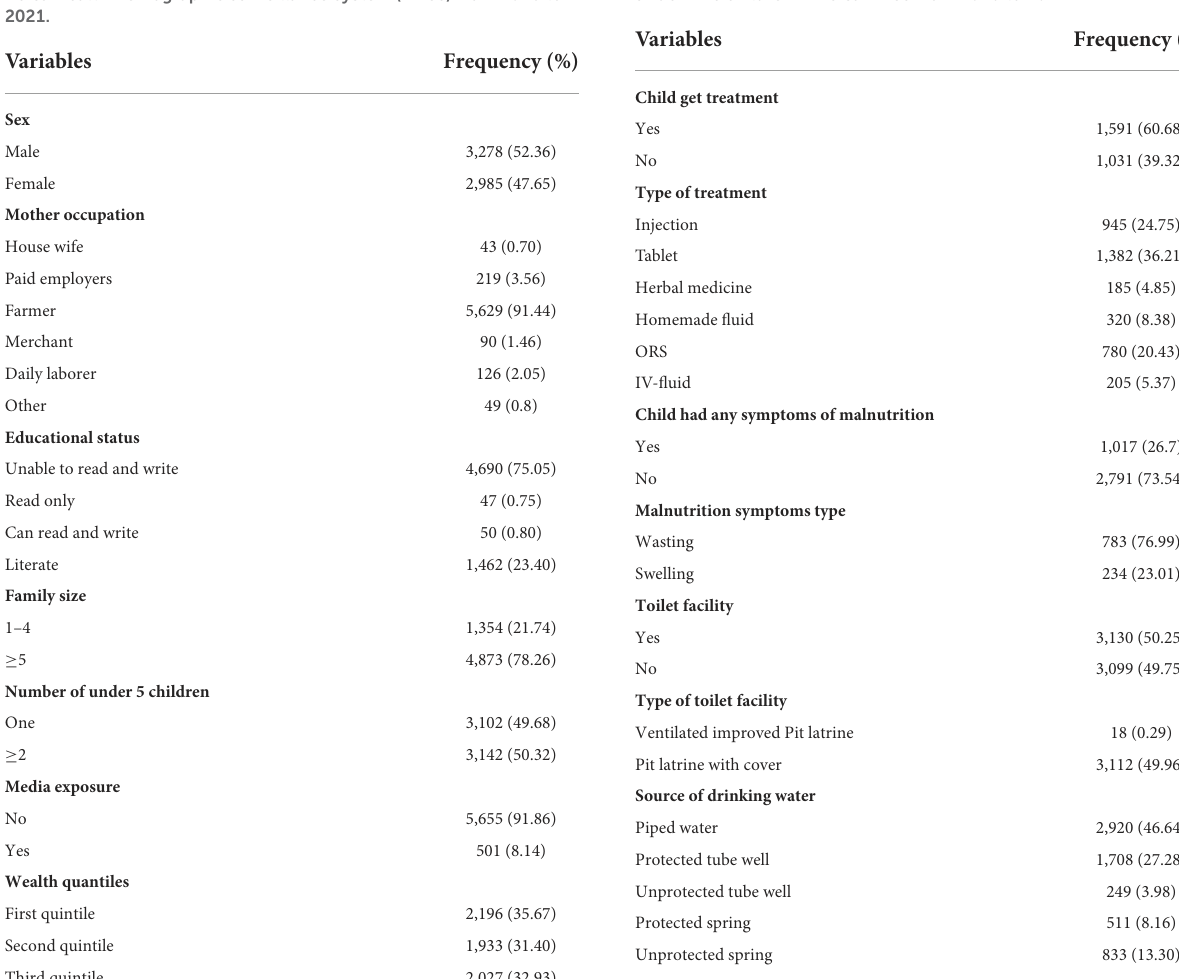
TABLE 2 Water sanitation and treatment-related characteristics of under-five children in Kersa HDSS from 2016 to